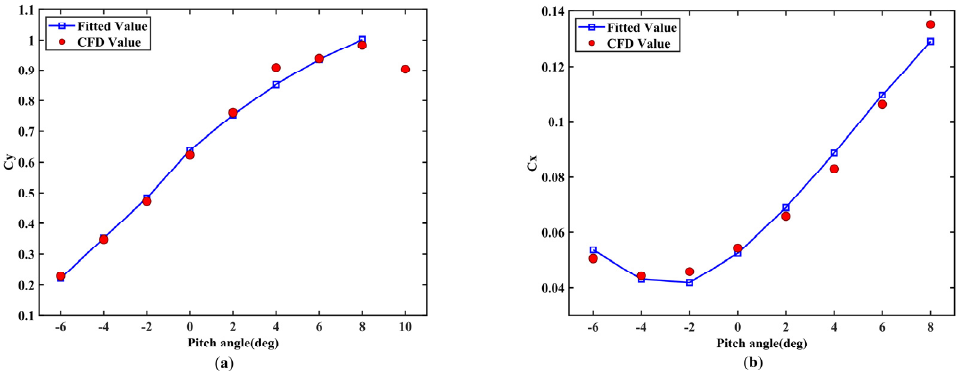
Figure 26. The Cy and Cx of aircraft in different pitch angles. ( a ) Cy fitted curve. ( b ) Cx fitted curve.